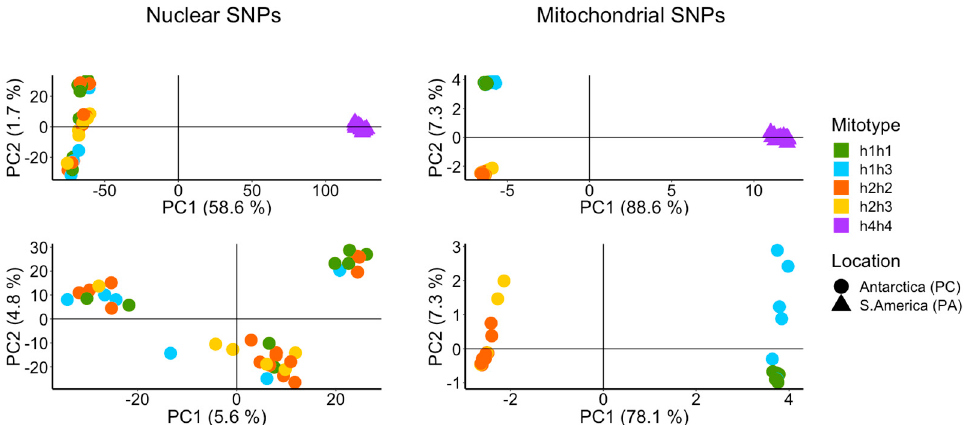
Figure 3. Principal component analysis based on 108,801 nuclear and 392 mitochondrial SNPs of Antarctic (circles) and South American (triangles) populations of A. eightsii . In panels below, only Antarctic specimens were included in the analysis. Nuclear and mitochondrial SNPs identify the samples from South America as a distinct group. Mitochondrial SNPs identify two groups among Antarctic samples characterized by haplotypes h1 or h2, respectively, either in homoplasmic condition or in heteroplasmic condition together with h3. Nuclear SNPs sort Antarctic samples into three groups that are not congruent with the mitochondrial conditions of the samples. Mitochondrial genotypes (Mitotypes) of the organisms are indicated with colors in both PCAs based on nuclear and mitochondrial SNPs.